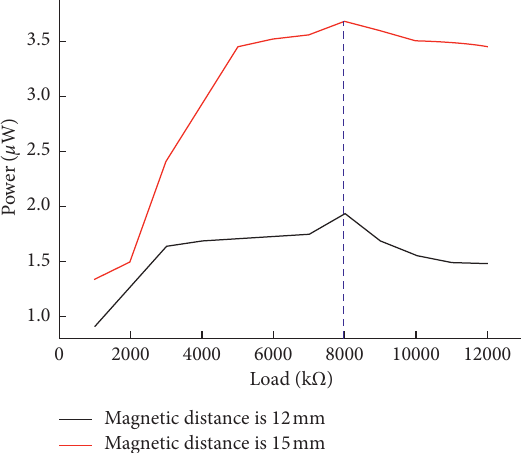
Figure 33: Relation of the power-loads of the system is given when the initial magnetic distances are selected as 12 mm and 15mm, respectively.